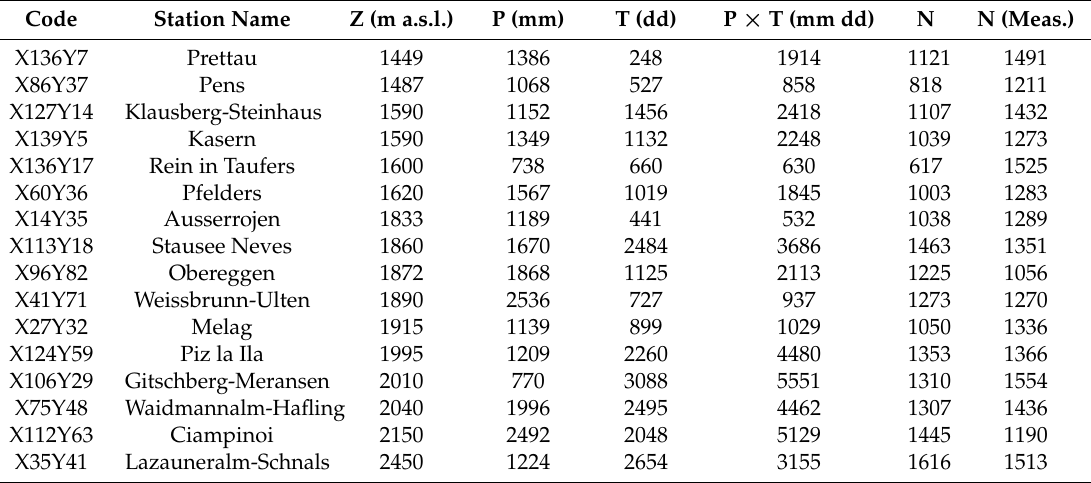
Figure 2 . Examples of scatter plots of estimated and observation-derived snow water equivalent (mm) at selected stations, and corresponding time series. On the right panes, red lines represent model simulations and blue dots represent snow water equivalent (SWE) derived from observed snow depth. Table 2. Snow depth measurement stations and explanatory variables (P = cumulative winter snowfall 2002–2010, mm; T = cumulative winter degree-days; P × T = cumulative rain on snow multiplied by daily degree-days; N = cumulative number of days with estimated presence snow cover; N (meas.) = cumulative number of days with snow depth > 0; Z = station elevation; dd = degree-days.